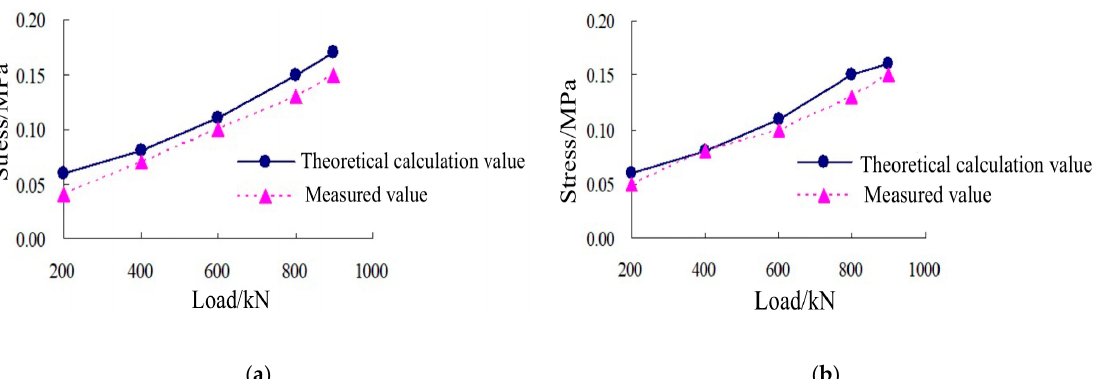
Figure 11. Diagram of stress of the upper concrete of the base plate. ( a ) Longitudinal stress; ( b ) lateral stress